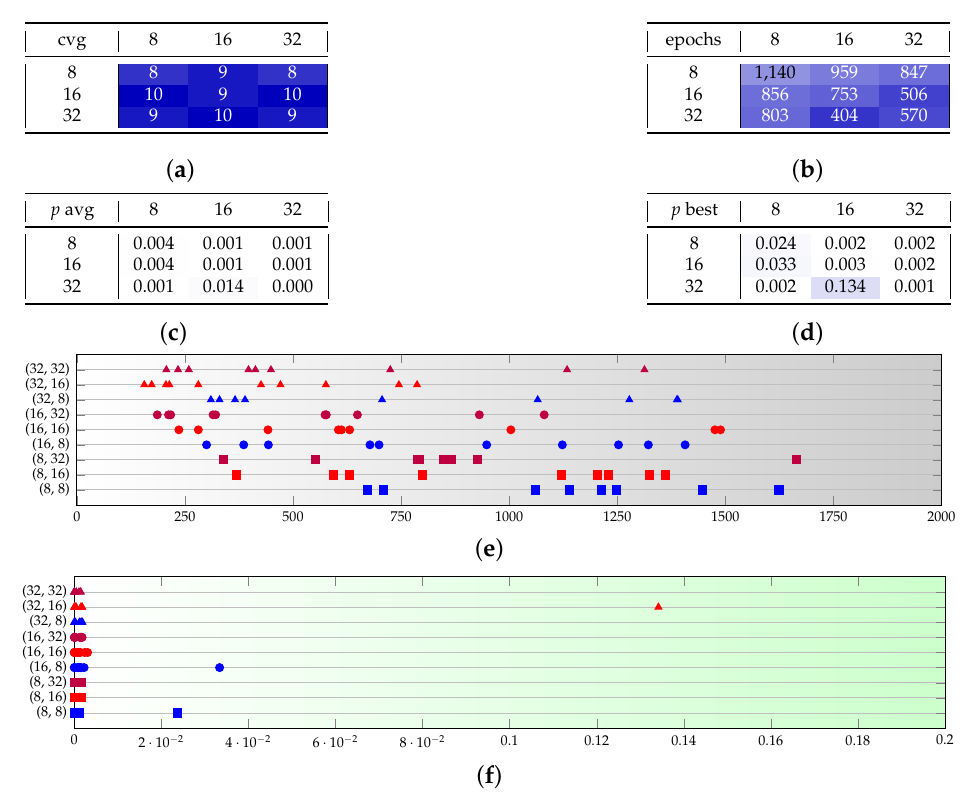
Figure A11. Test set J provides a sensitivity analysis on the discriminator size for n = 4. ( a – d ) The rows represent H 1 and the columns H 2 . ( e , f ) The couples on the vertical axis are ( H 1 , H 2 ) . The marker shapes represent H 1 and marker colors represent H 2 . ( a ) Converging runs, out of 10. ( b ) Number of epochs before convergence, on average. ( c ) p -value for the χ 2 test once convergence is reached (average over converging runs). ( d ) p -value for the χ 2 test once convergence is reached (best run). ( e ) Visual representation of the epochs before convergence. ( f ) Visual representation of the p -value, zoomed on p 0.2 as no points have p > ≤